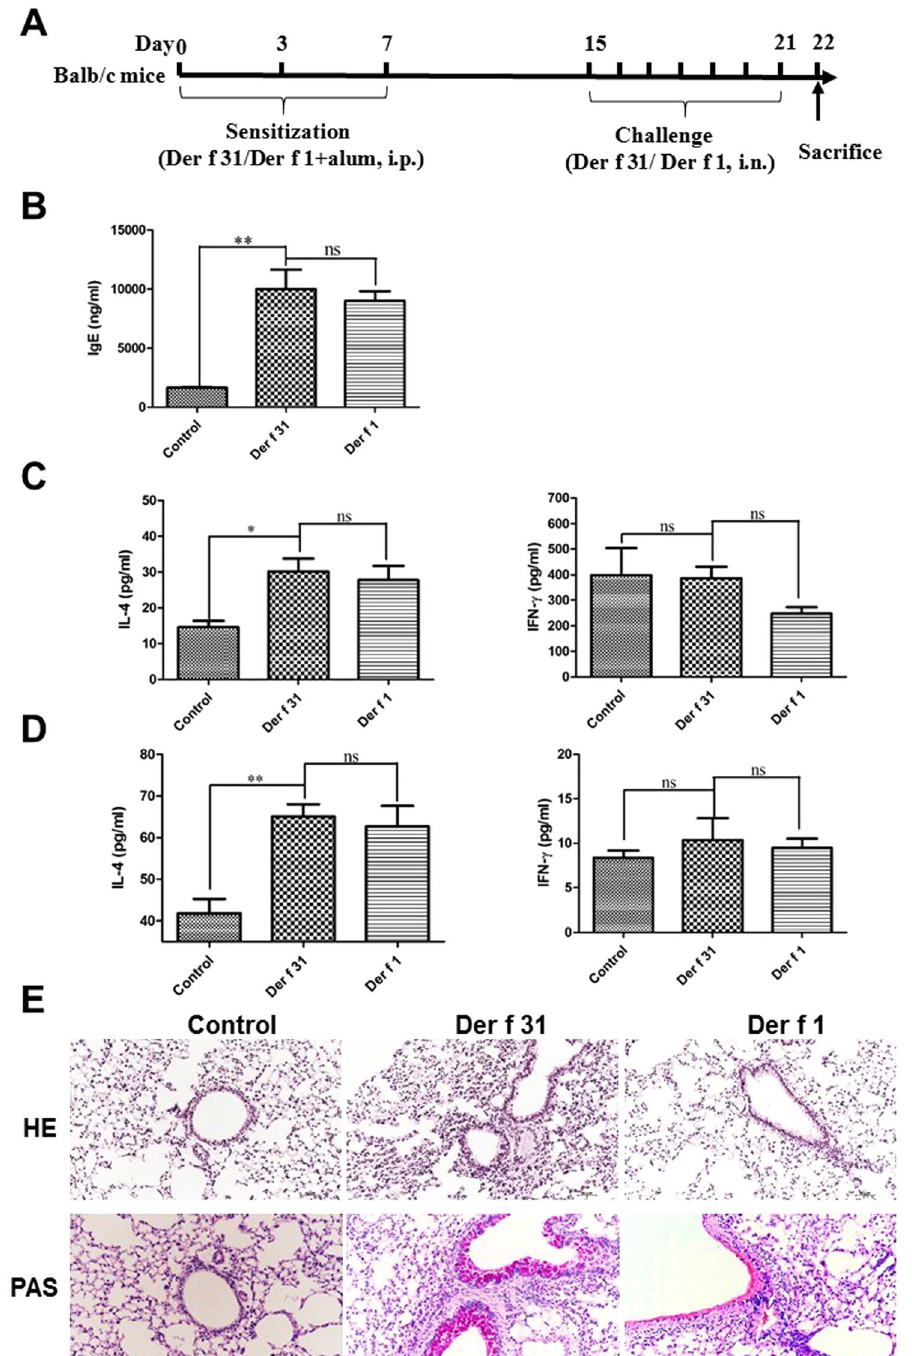
Figure 4. Airway allergy is induced by Der f 31. Four- to 7-week-old female BALB/c mice were immunized with PBS, Der f 31 or Der f 1 and then challenged with Der f 31 or Der f 1 for one week. ( A ) The scheme of establishment of mouse model. ( B ) Total IgE, allergen-specific IgE, IgG1 and IgG2a were detected by ELISA by optical density (OD). ( C ) The cytokines in BALF. ( D ) The cytokines in the lung homogenates. E, Histological sections of lung tissues. These data (means ± SEMs) were generated from one of three experiments (n = 6) and processed with GraphPad software. The significant differences between two groups were tested by two-tailed T-test. ** p < 0.01. *** p < 0.001. ns, no significant